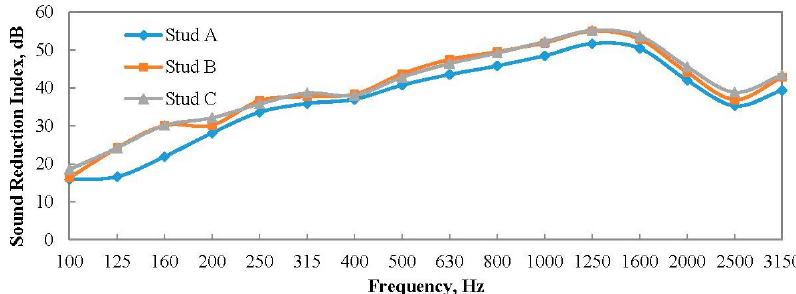
Figure 11. R values from experimental test for a metal-framed wall using various stud geometries.